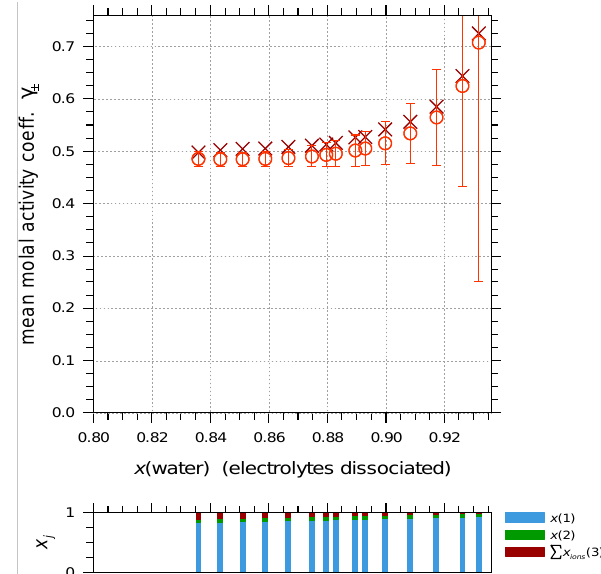
Fig. 7. Mean molal activity coefficients γ ± of KCl in the system water (1)+ethanol (2)+KCl (3) at 298K. Experimental values ( ) derived from EMF measurements by Lopes et al. (1999), calculated γ ± values ( ) and corresponding activity coefficient sensitivities (error bars) are with regard to the mixed solvent reference state def-